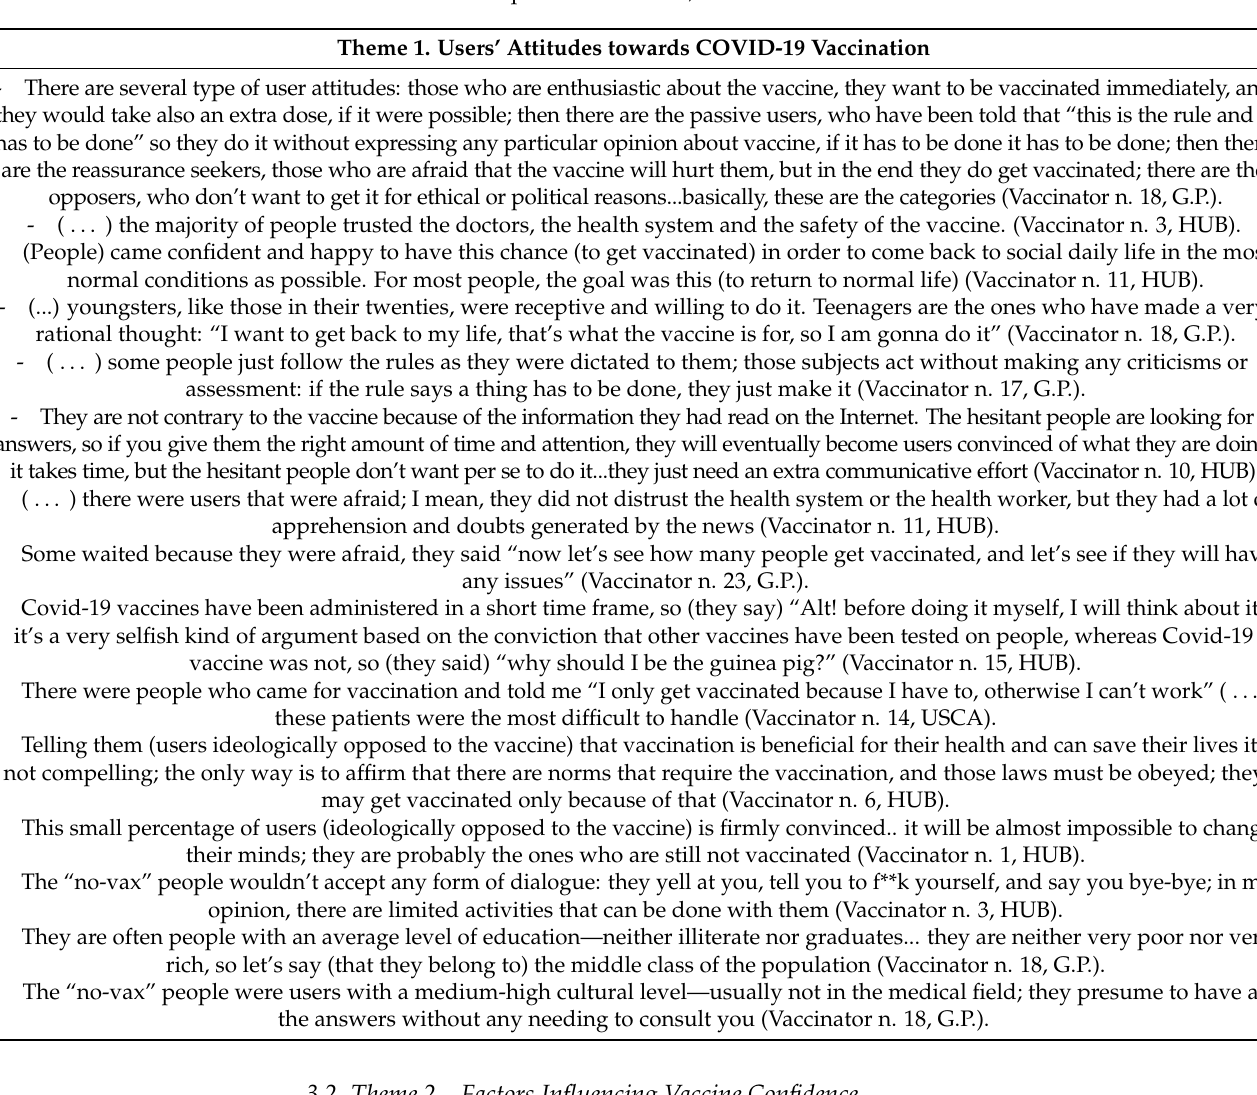
Table 2. Illustrative quotes for theme 1, “users’ attitudes towards COVID-19